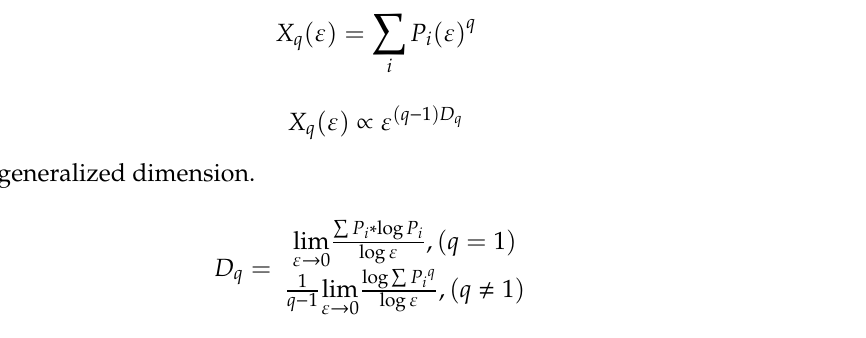
Figure 3. Cumulative number plots of the earthquakes versus time for all events with M ≥ 1.0 and declustered events with M ≥ 3 in the Taiwan region.